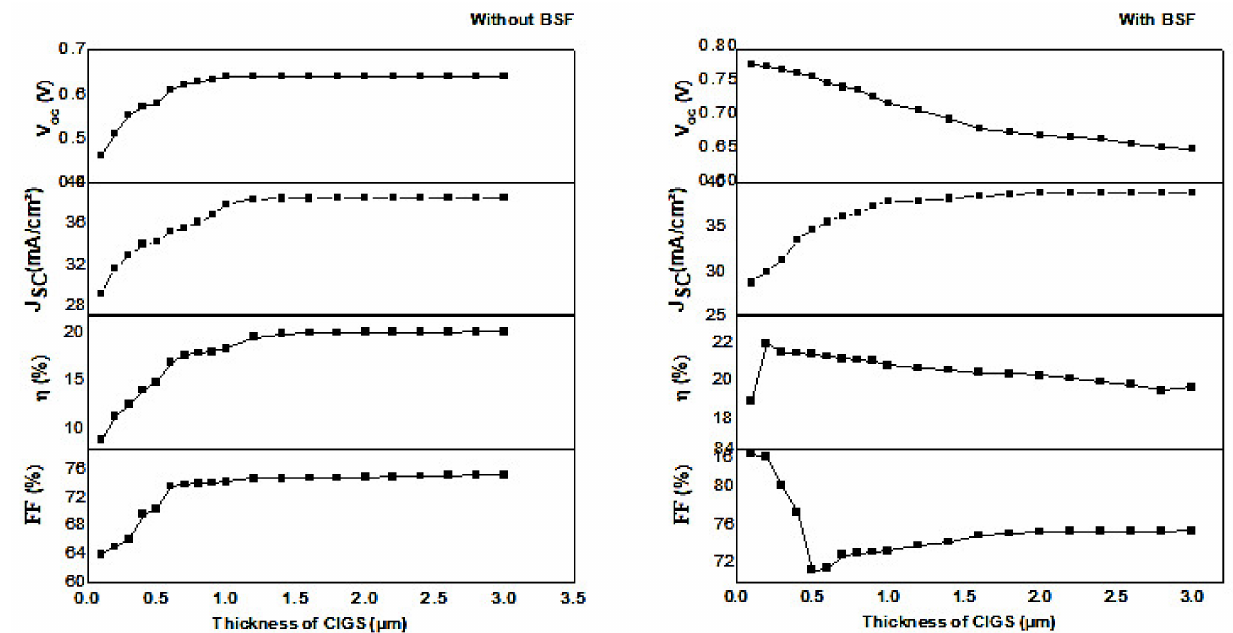
Figure 5. The performance of the solar cell without and with BSF as a function of CIGS